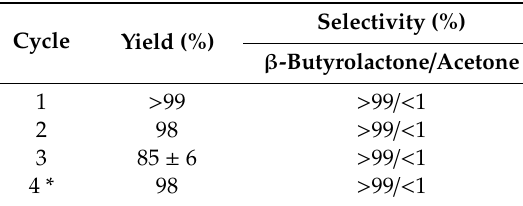
Table 2. Recyclability of